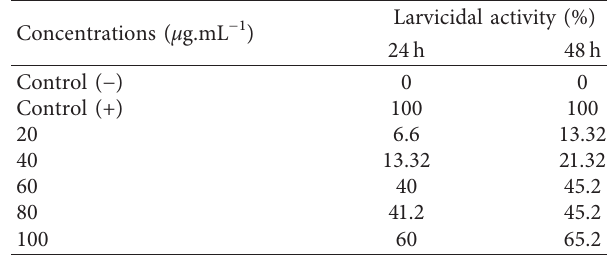
Table 2: Percentage mortality (%) of A. aegypti larvae at different concentrations of essential oil of T. procumbens leaves at 24 and 48